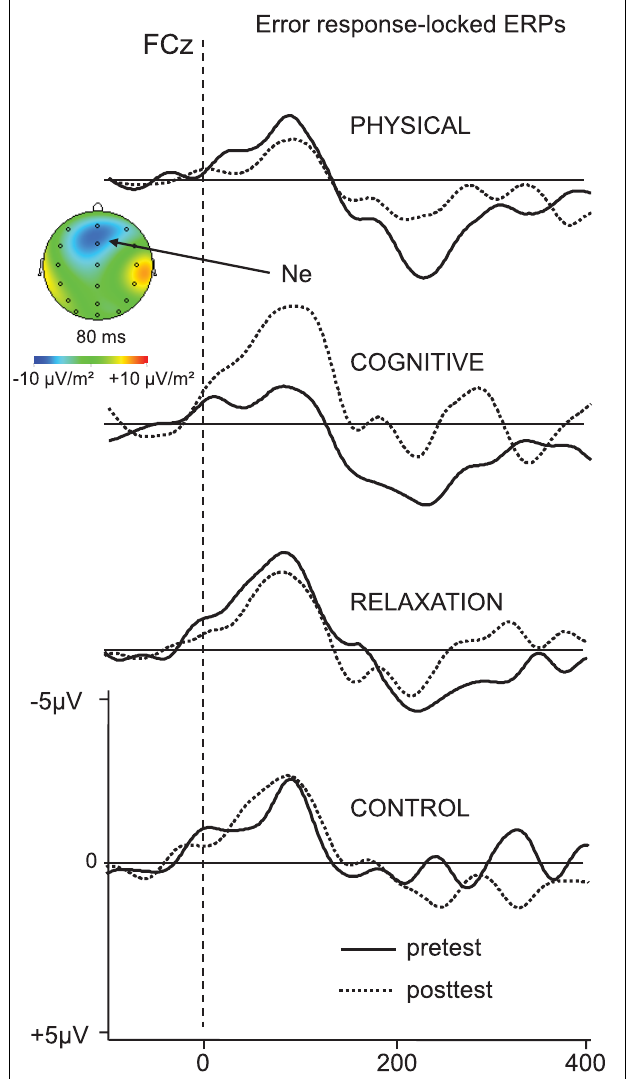
FIGURE 6 | Error-response-locked ERP – waveforms collapsed across non-switch and switch trials as a function of pre- (solid) and post-test (dotted) and participant’s group at FCz. Negativity is plotted